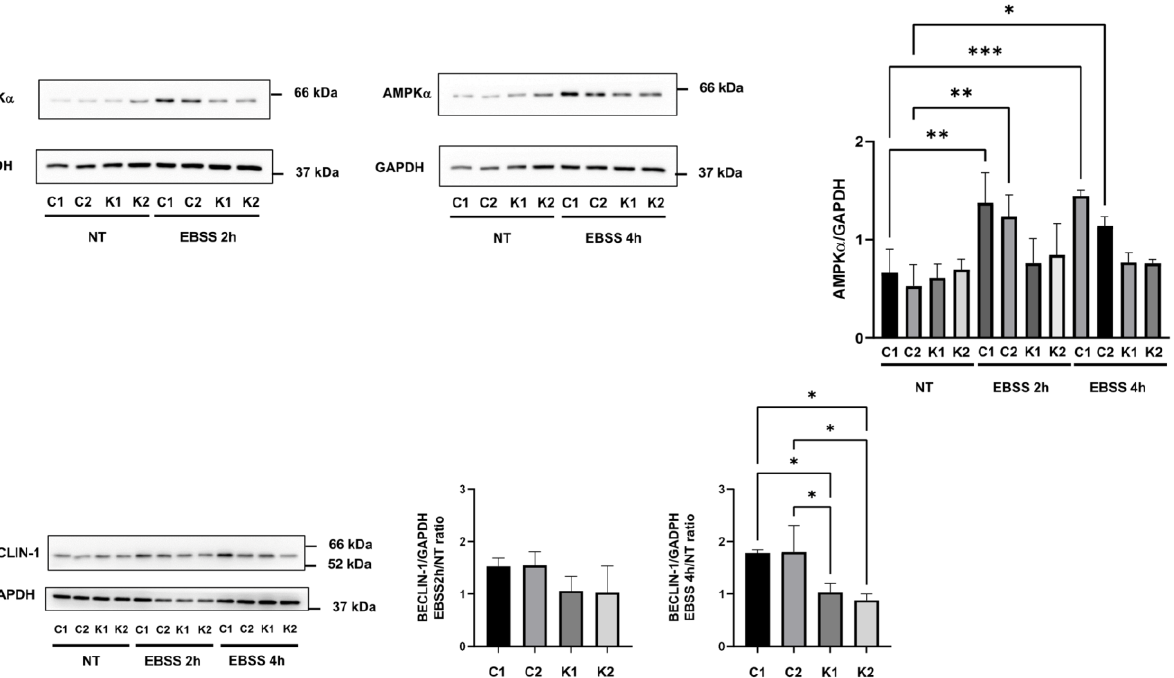
( B ) beclin-1 in growth conditions (NT) and after incubation with EBSS for 2 h and 4 h. Beclin-1